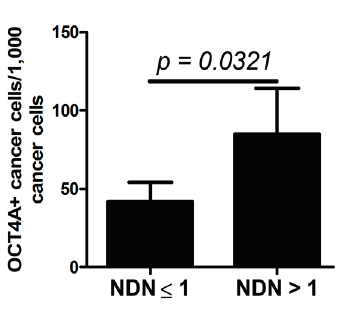
Figure 6. Percentage of low-intensity OCT4A-postive cells in relation to NDN status. The significant differences are denoted by p -values ( t